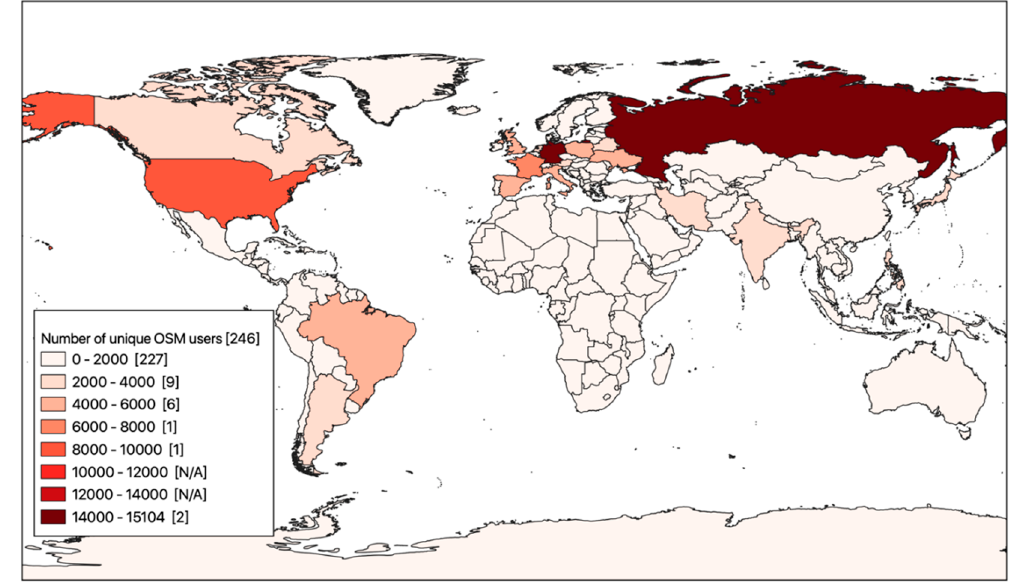
Figure 5. Distribution number of OSM Notes posted by unique OSM account by country.